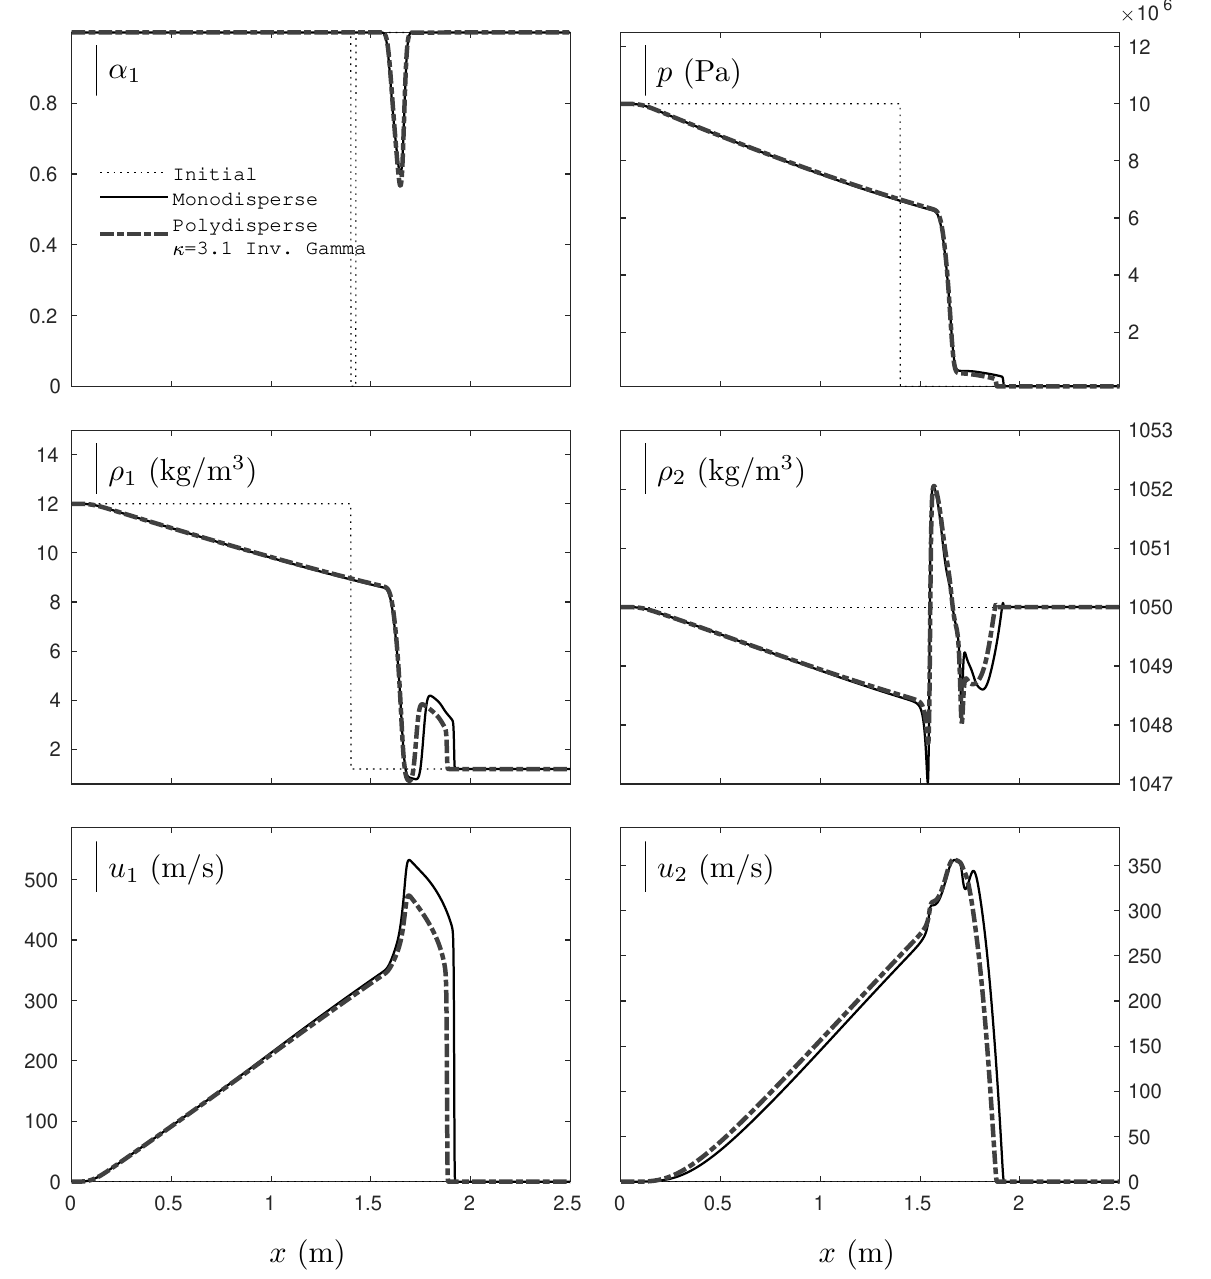
Figure 12: Simplified two-phase explosion test depicted in Fig. Figure 12. Simplified two-phase explosion test depicted in Figure 5. Comparison of the monodisperse and polydisperse results. The initial specific interfacial area is the same for both computations monosdisperse radius of R t =0 = A t = 0 A t = 0 and is computed via an initial monodisperse radius of R t = 0 2 I ,mono. I ,poly.